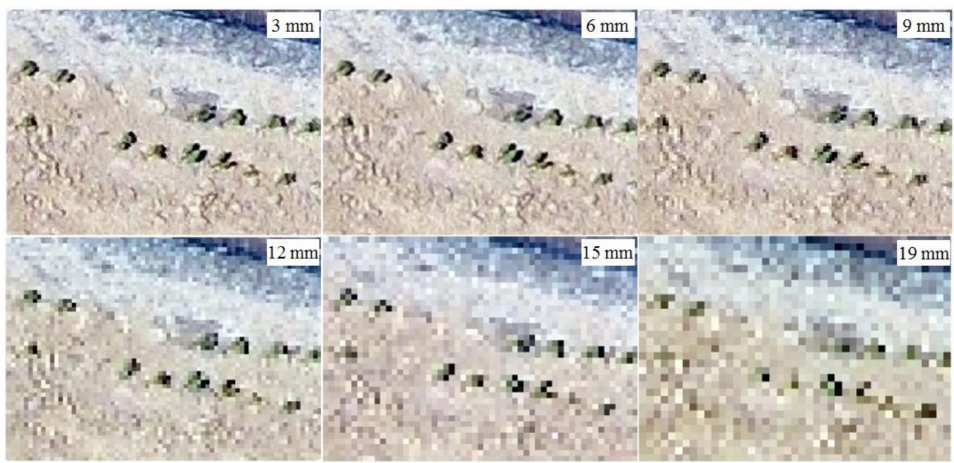
Figure 7. The cotton field images at di ff erent resolutions obtain from the